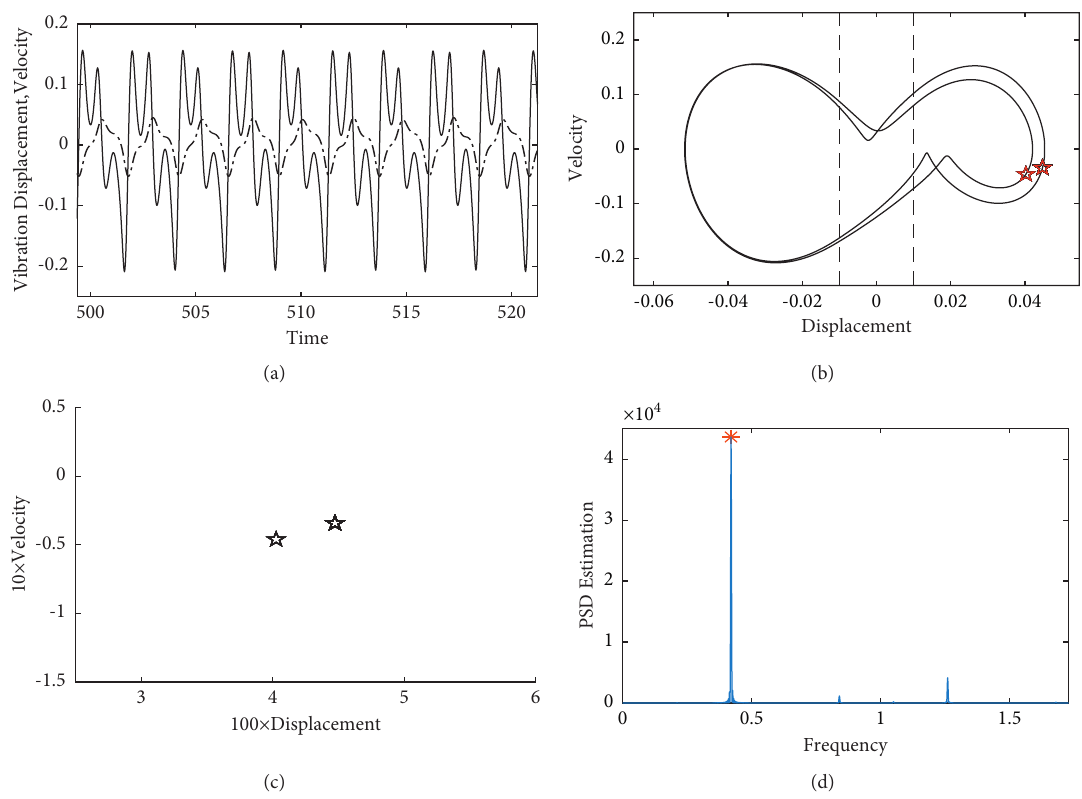
Figure 6: f � 0 . 420 Hz ， asymmetric period 2-2-2. (a) Time history graph. (b) Phase diagram. (c) Poincar´e section. (d) Power spectral density